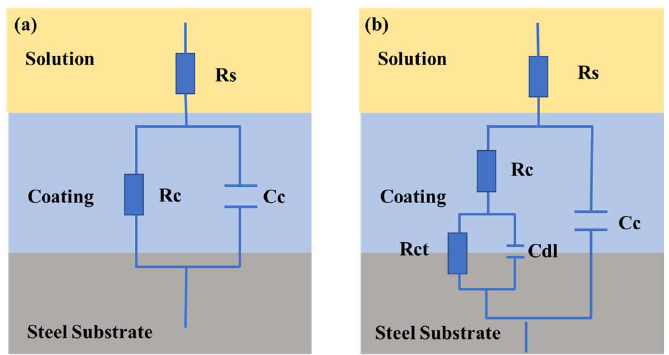
Figure 11. ( a ) Early equivalent circuit; ( b ) mid-late equivalent circuit.